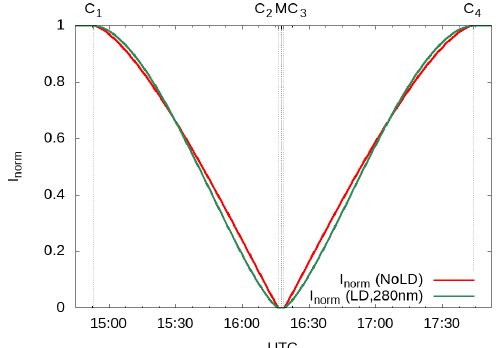
Figure 4: Eclipse Light curve with no LD (red), with LD